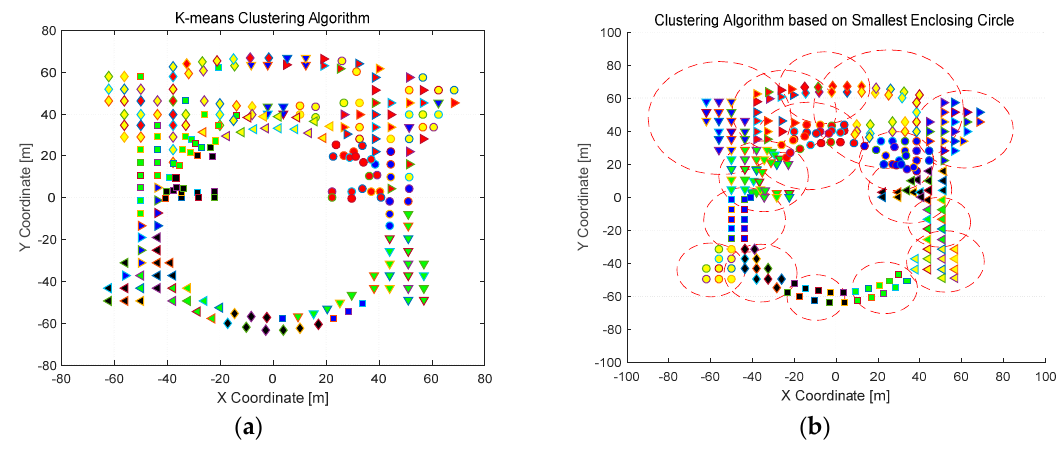
Figure 8. Clustering results comparison in Test-bed 1: ( a ) clustering results under K-means clustering algorithm; and ( b ) clustering results under Smallest Enclosing Circle (SEC)-based clustering algorithm.